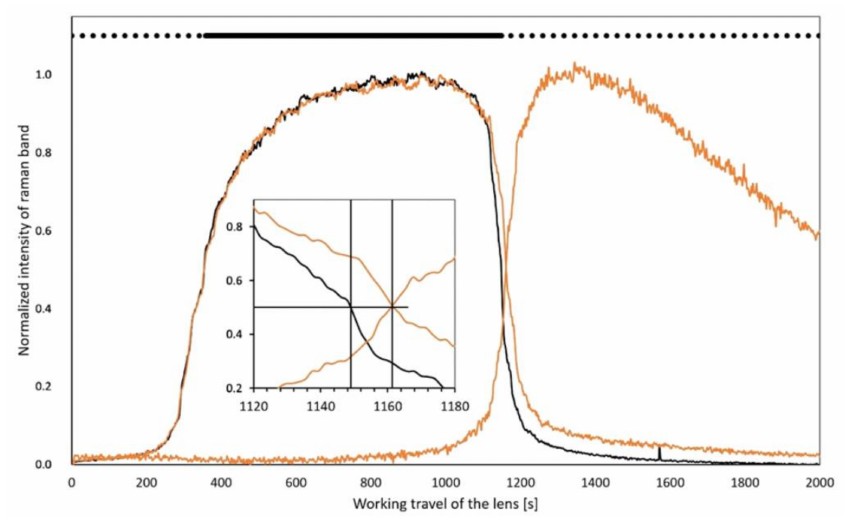
Figure A4. Concentration profile of an interface between a PC bar coated film and a drop of